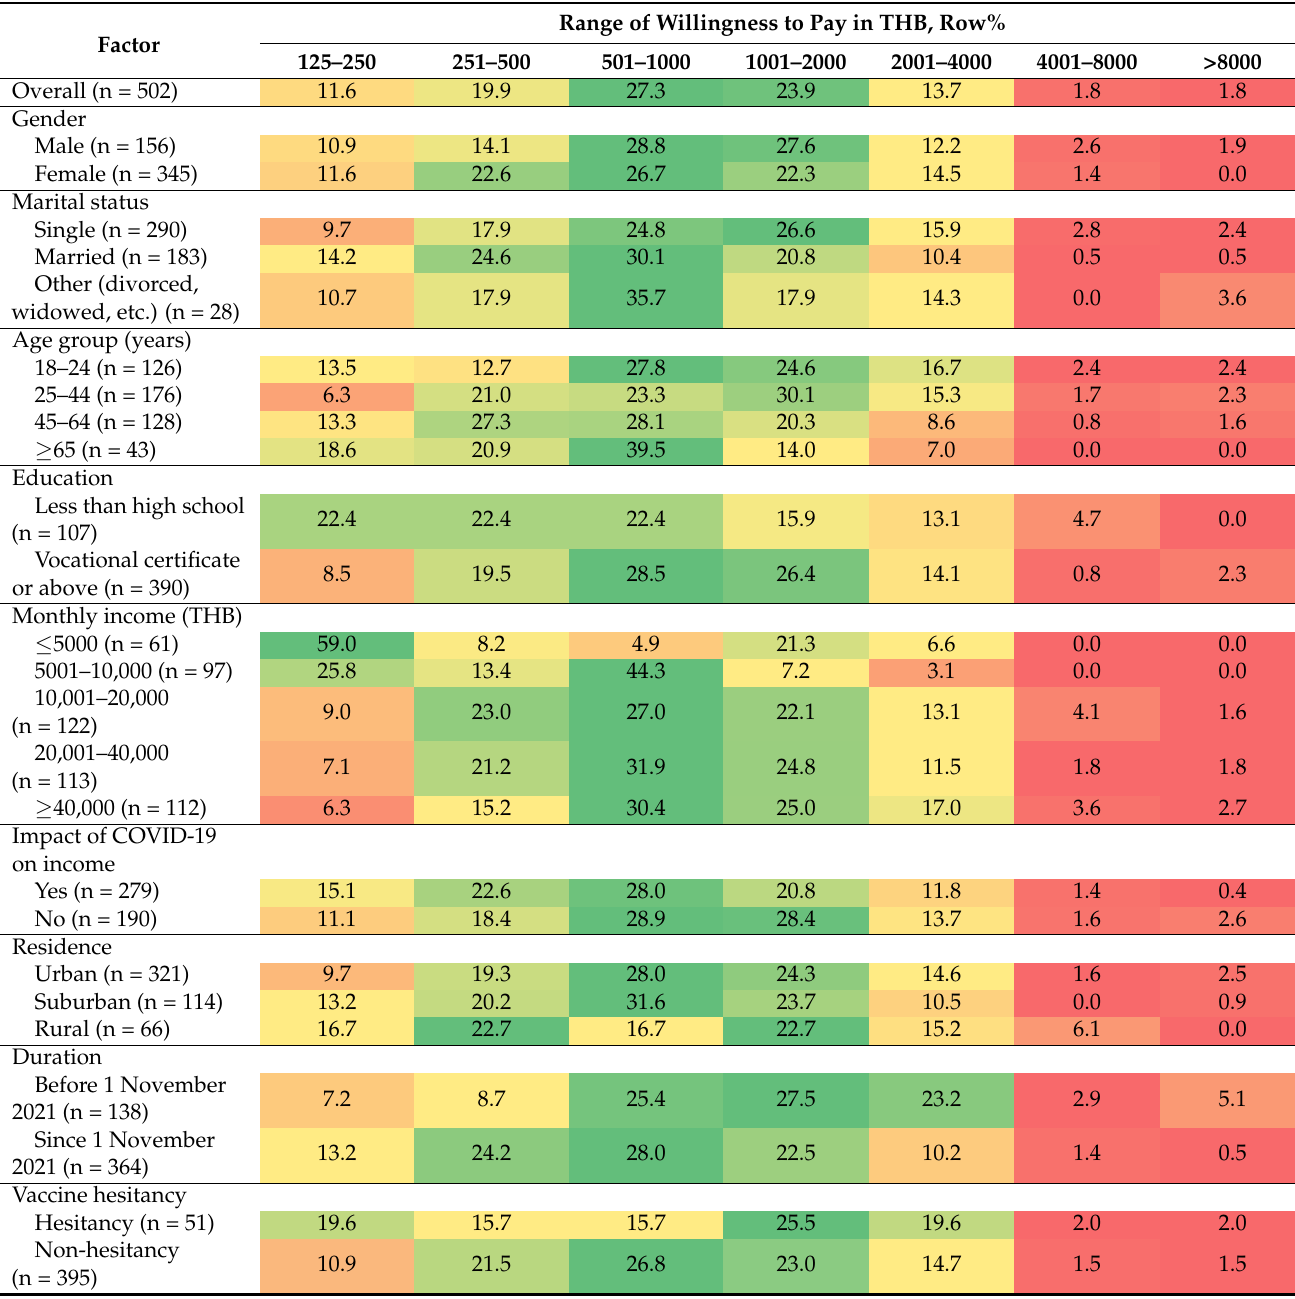
Table 7. Relationship between the range of willingness to pay for COVID-19 vaccine and demographic data and vaccine hesitancy (n =